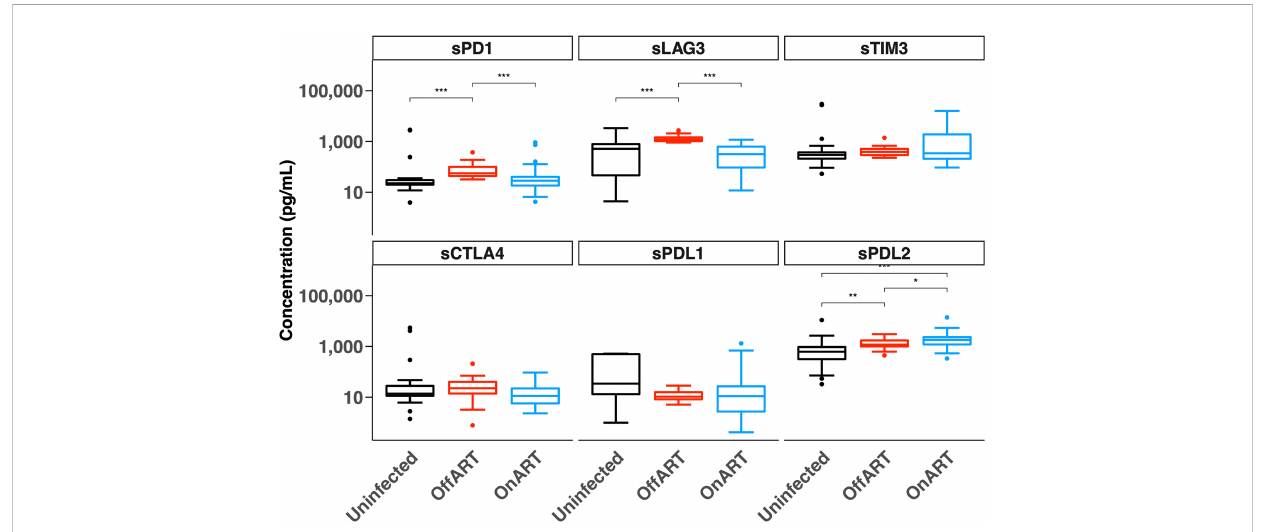
FIGURE 1 Concentration of soluble immune checkpoint proteins in HIV-uninfected participants and people with HIV off antiretroviral therapy (Off ART) and on suppressive antiretroviral therapy (On ART). Box plots show the median, 25 th and 75 th percentiles within the box and 10 th and 90 th percentiles in the error bars. The two-sample Wilcoxon test was used for comparisons between groups. *p < 0.05, **p < 0.01, ***p < 0.001. Soluble (s), Programmed Cell Death protein 1 (PD-1), Lymphocyte Activation Gene-3 (LAG-3), T cell Immunoglobulin domain and Mucin domain 3 (TIM-3), Cytotoxic T- Lymphocyte-Associated protein 4 (CTLA-4), PD-1 Ligand 1 (PD-L1) and PD-1 Ligand 2